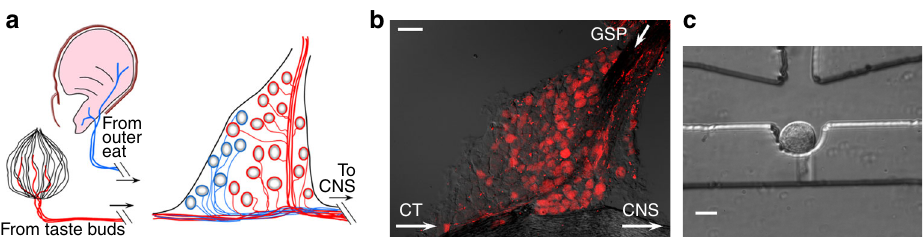
Fig. 1 Peripheral targets innervated by geniculate ganglion sensory neurons. a . Gustatory afferent fi bers from taste buds in anterior tongue and palate (red) and somatosensory fi bers innervating the pinna (blue) converge in the geniculate ganglion where their somata reside. b . Cryosection of a geniculate ganglion following anterograde labeling of gustatory nerves (GSP, CT) with tetramethylrhodamine dextran. Taste neurons are red while somatosensory neurons in the ganglion remain unstained. Arrows indicate direction of propagation of sensory signals from peripheral targets. c . A geniculate ganglion neuron in a Fluidigm chip capture site. Several ganglia were dissociated and processed for cell capture (see Methods). 96 such singly captured neurons were sequenced to yield data on neuronal cell types. Scale bars , b , 50 μ m c , 20 μ